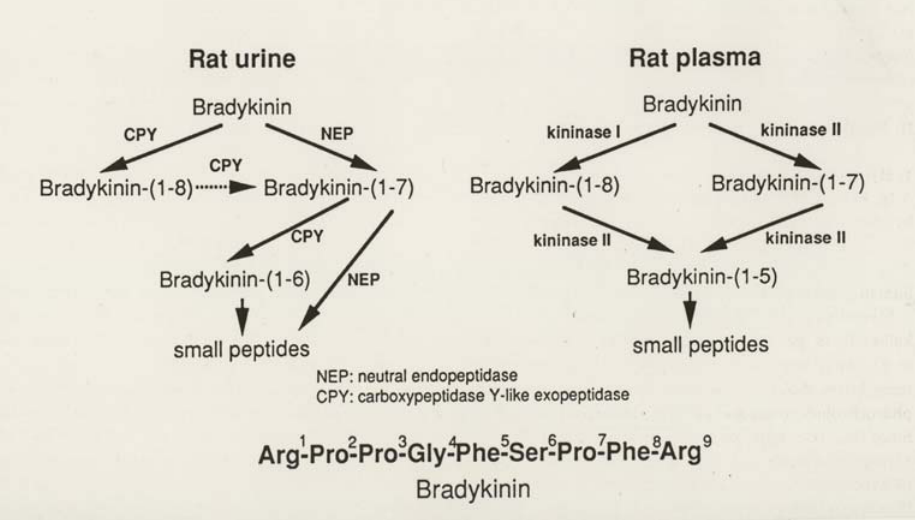
Figure 2. Pathways of bradykinin (BK) degradation by rat plasma and rat urine. BK(1-n) indicates BK degradation products with n amino acids from the N -terminal (reproduced from Ref. [9], with